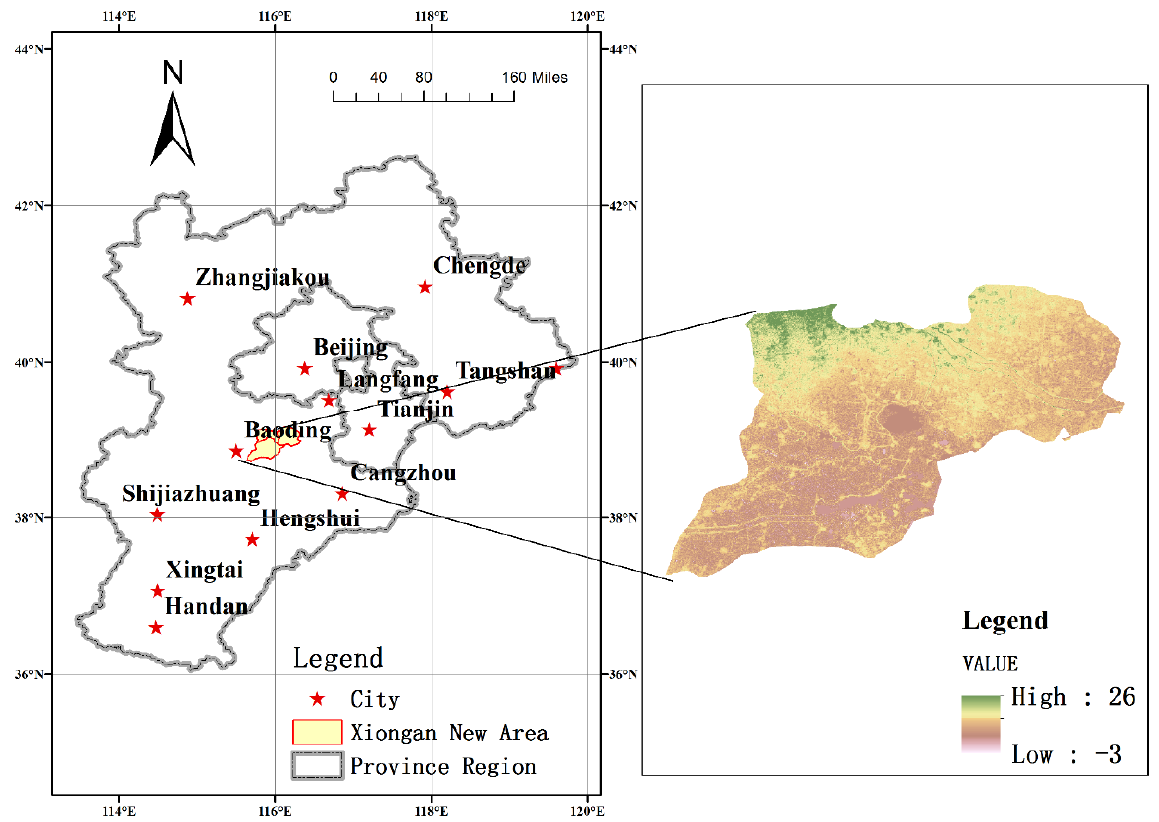
Figure 5. Overview of the study area.